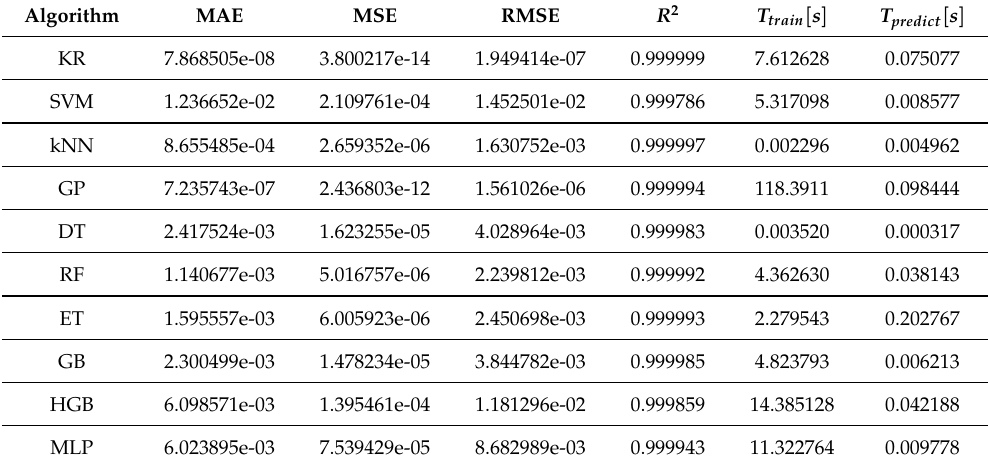
Table 3. Comparison of several machine learning algorithms for regression of relaxation rate terms. Reproduced from [40] with